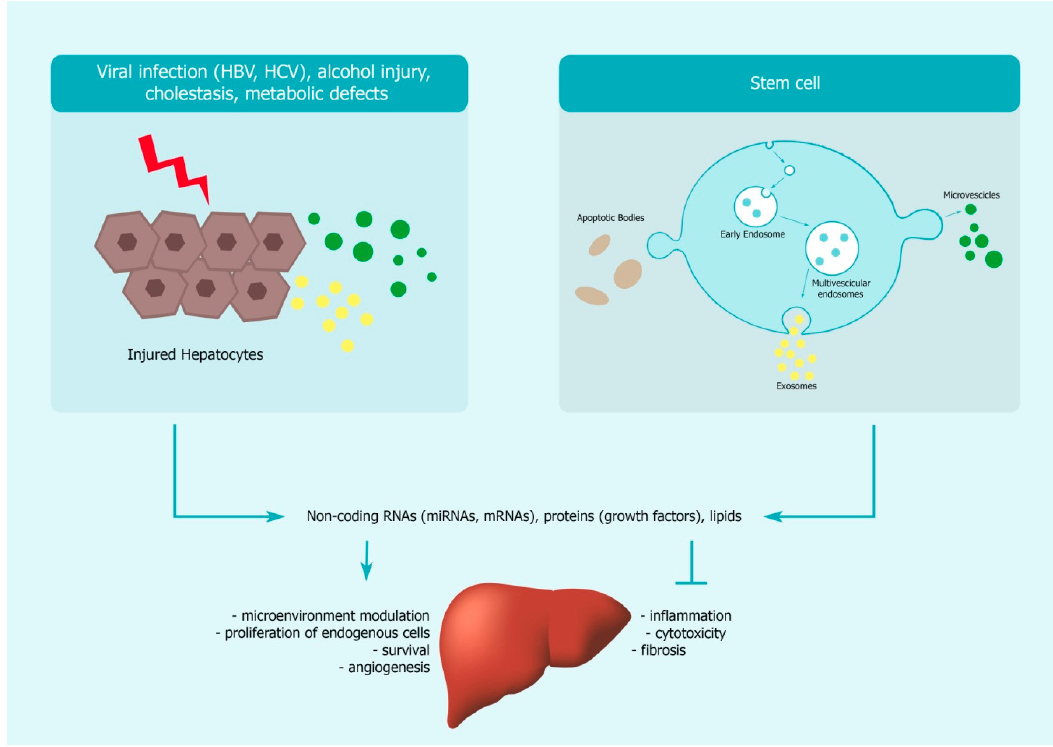
Figure 4. Action of EVs on liver repair. Upon injury, hepatocytes release EVs containing restorative non-coding RNAs, proteins and lipids that induce the regenerative process in the liver by enhancing survival and proliferation of resident cells, neovascularisation, and by modulating niche homeostasis. Stem cell therapy potentiates this process by providing EVs with anti-inflammatory and immunomodulatory properties to the damaged liver. These EVs may have anti-fibrotic effects and prevent cytotoxicity in the liver, hence contributing to slowing the progression to end-stage liver diseases.